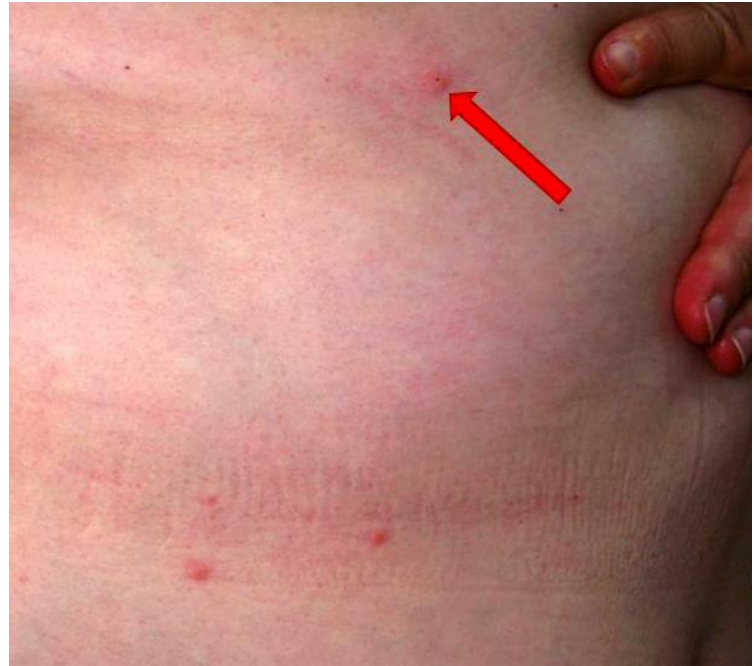
FIGURE 1. Numerous, intensively pruritic, erythematous papules on the patients’ trunk. The arrow shows the site of the dermoscopic picture.